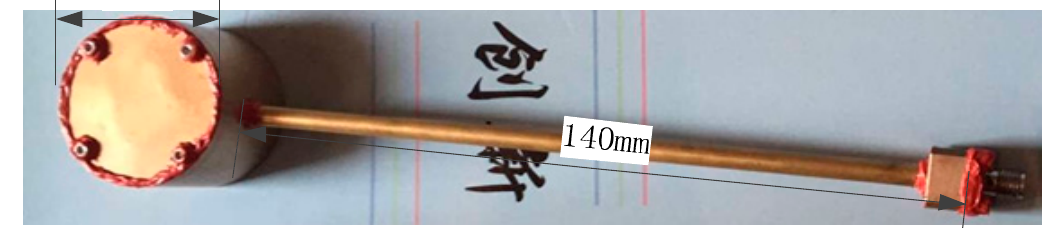
Figure 2. Demo of the microwave wire interrogation, high-temperature pressure sensor.